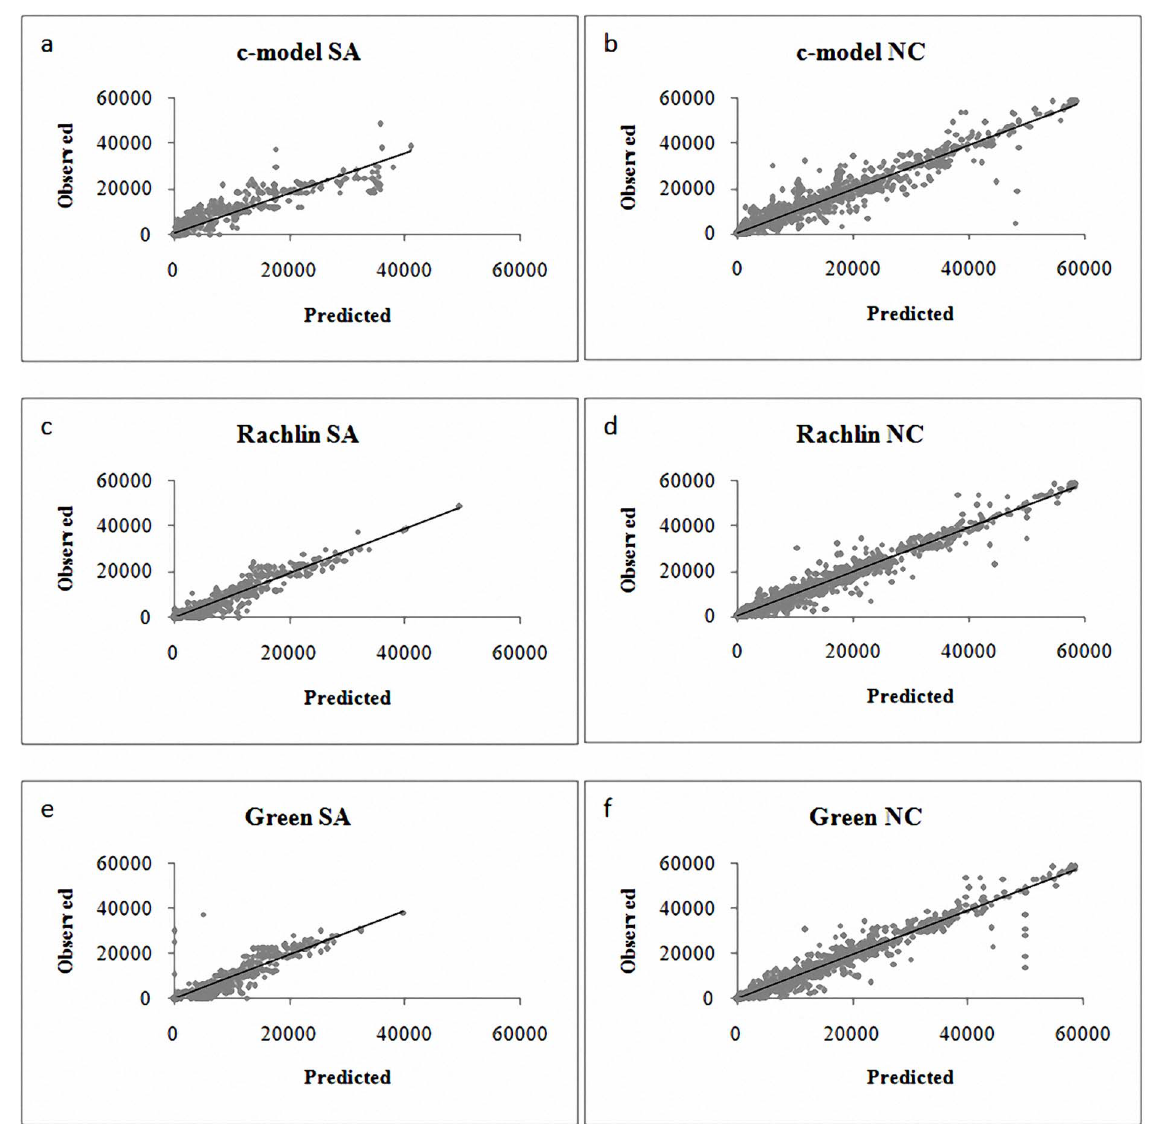
Figure 3. Scatter Plots of Predicted and Observed Indifference Points for Each Model in each SA and NC Groups.